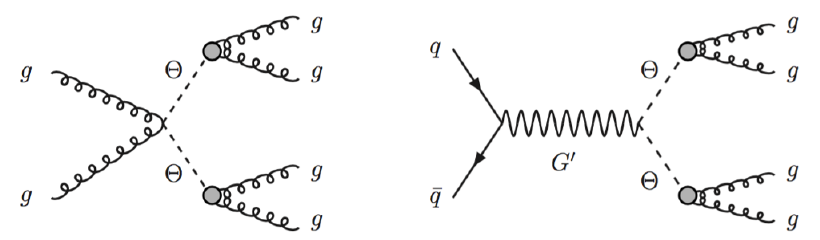
Figure 8 . Pair production of the color-octet scalar (cid:2), through QCD (left-hand diagram; related diagrams with only trilinear vertices are not shown), and coloron decay (right-hand diagram), followed by (cid:2) decays into two gluons at one loop. The branching fraction for (cid:2) 100% when M (cid:2) < M (cid:30) I